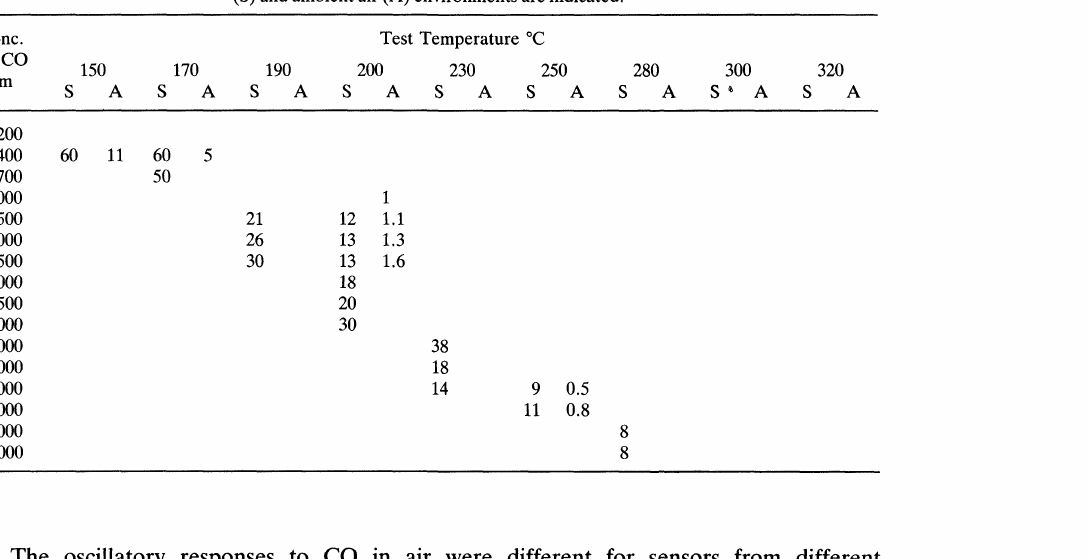
TABLE IV Periods ofthe oscillations in seconds in Sample 2 at different test temperatures and CO concentrations. Synthetic air (S) and ambient air (A) environments are indicated.